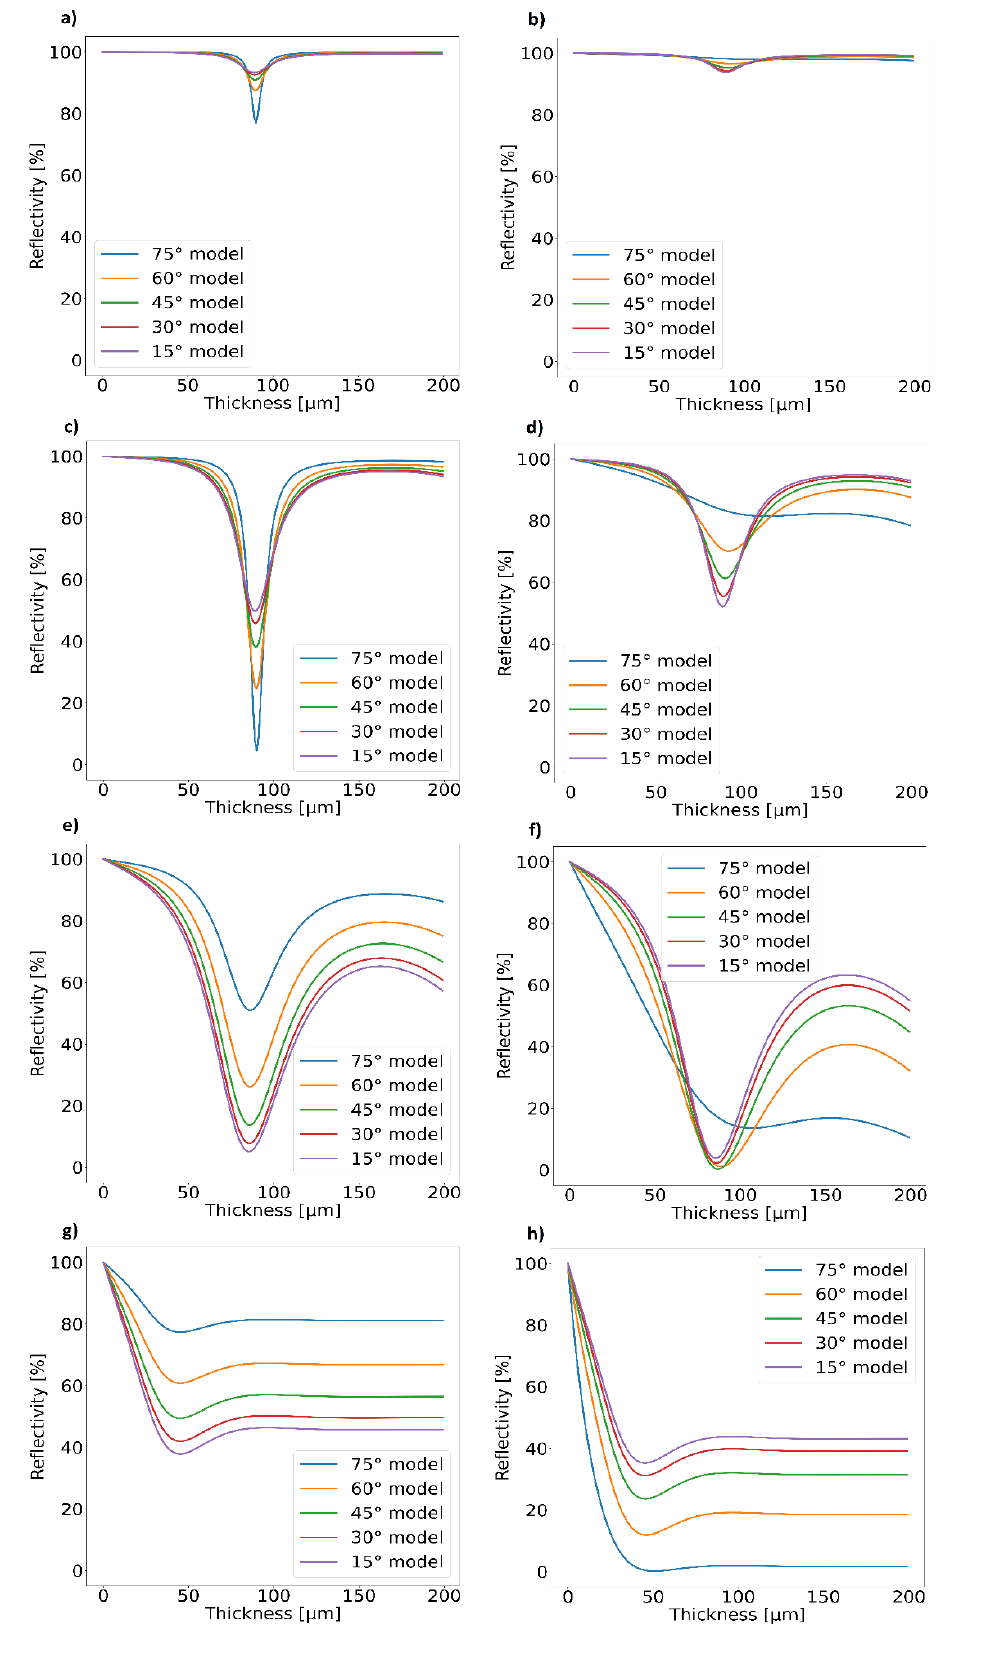
Fig. 4. Modeled data for the result of a change in absorption coefficient on the thickness dependency with a refractive index of 5. Left column is orthogonal, right one parallel polarization, the absorption coefficient from top to bottom is 1, 10, 100,